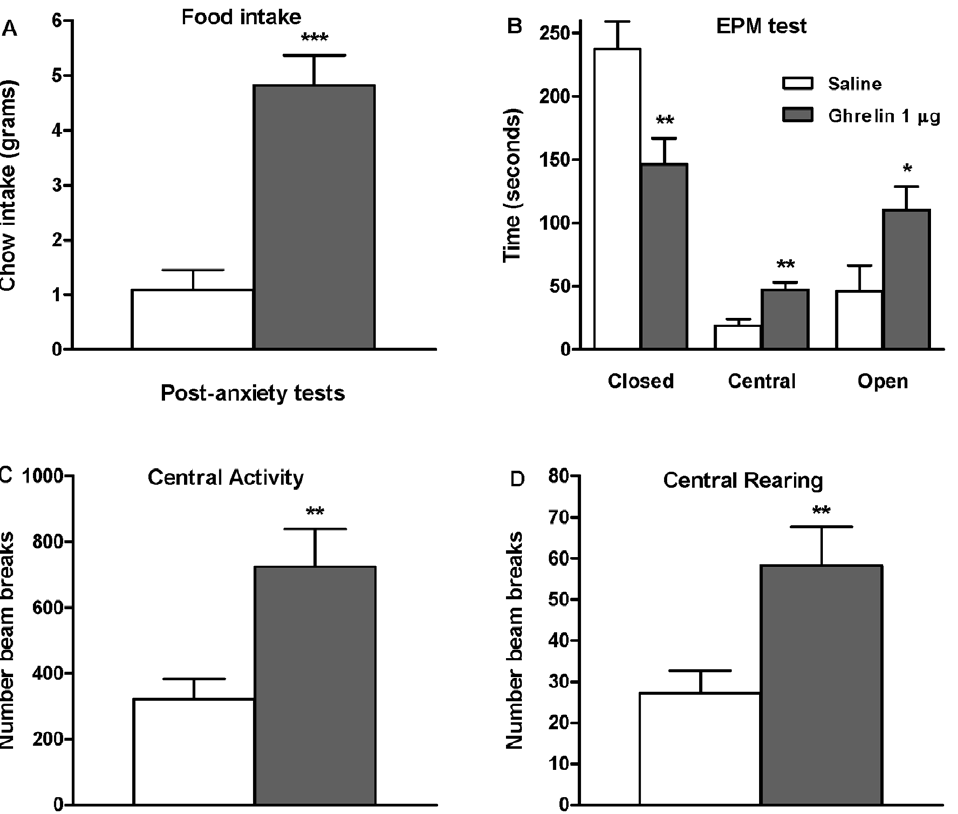
Figure 7. Effects of intra-amygdala administration of ghrelin on anxiety-like behavior in rats denied access to food. In this ‘‘FOOD WITHHELD’’ paradigm rats were denied access to food during the first hour after intra-amygdala injection. (A) An orexigenic response to intra- amygdala ghrelin injection was detected when animals were returned to their home cages after the anxiety testing. Intra-amygdala ghrelin injection decreased anxiety-like behavior relative to saline controls, reflected by an increase in the amount of time spent in the open arms in the EPM test (B) and by the increase in central activity (C) and central rearings (D) in the open field test. *P , 0.05 **P , 0.01, ***P , 0.001, vs. saline. Independent samples t-test, SPSS.